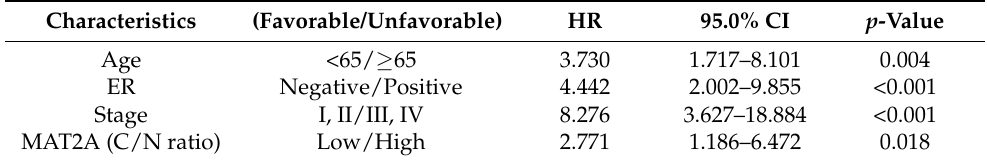
Table 2. Results of multivariate Cox regression model for age, stage, and C/N ratio of MAT2A